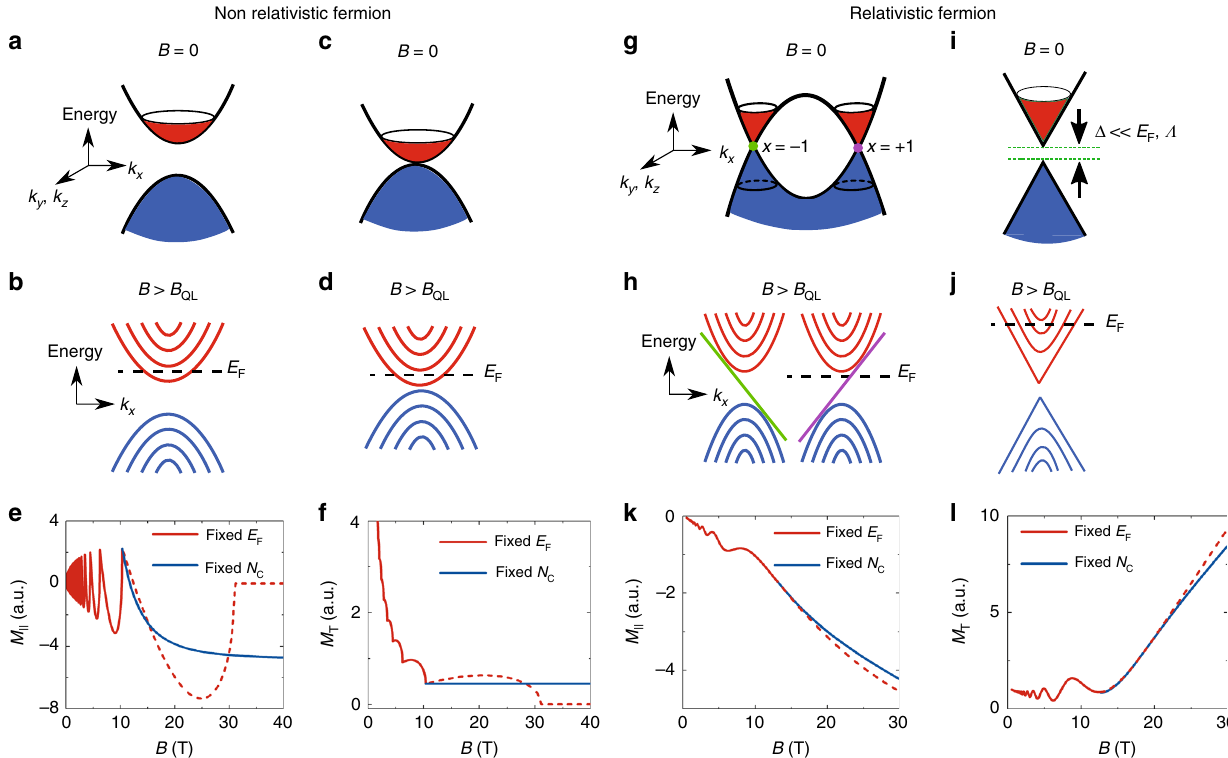
Fig. 1 Magnetic responses of the non-relativistic and relativistic fermions. a The energy bands of non-relativistic (parabolic-band) fermions in zero magnetic fi eld. b The LBs of non-relativistic fermions form in a magnetic fi eld. Only the 0th LB crosses the E F in the QL. c Two energy bands of non- relativistic (parabolic-band) fermions touch each other in a momentum point in zero magnetic fi eld. d The LBs of non-relativistic fermions touch each other in a magnetic fi eld. e, f Calculated parallel magnetization ( M || ) and effective transverse magnetization ( M T ) of non-relativistic fermions (the two cases show identical behaviors in the QL, here we just show a representative one for brevity) as functions of magnetic fi eld. We used two constraints for the calculation in the QL: fi xed the E F (red line) and fi xed carrier density ( N c ) (blue line). g A typical schematic energy band of a pair of type I Weyl nodes in zero magnetic fi eld. h A series of LBs for a pair of Weyl nodes form in a magnetic fi eld. Two 0th LBs are entirely chiral (green and violet). i A typical relativistic fermion band (Dirac model) with a small gap. The gap is much smaller than the cutoff energy Λ . This model also gives out the same non- saturating behavior as we see in the Weyl case. j The corresponding series of LBs for a simple Dirac model with a small gap in a magnetic fi eld. k, l Calculated M || and M T as functions of magnetic fi eld, respectively. The two cases show identical behaviors in the QL, and here we just show a representative one for